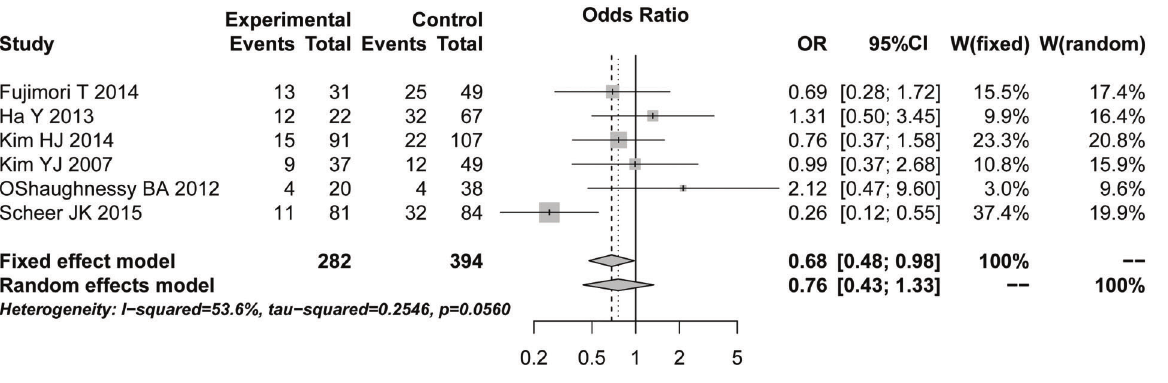
Figure 6. Forest plots for revision rate. UT (experimental group): upper thoracic; LT (control group): lower thoracic. See Table 1 for reference numbers of cited